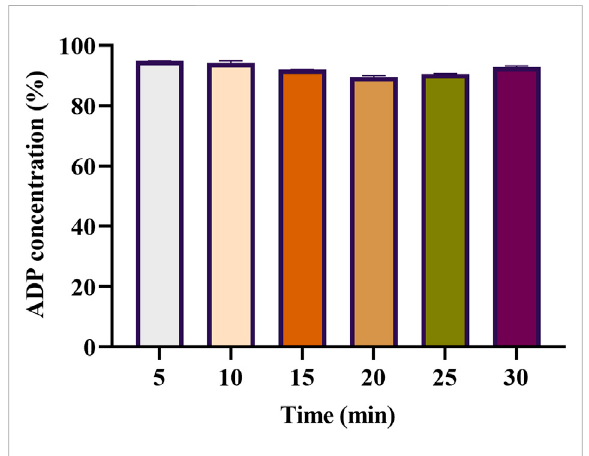
FIGURE 3 Graphical representation of the in vitro dissolution study for the assessment of the release of adapalene from the mucoadhesivevaginalgel( n =3).Thenumericvaluesonthe y -axis represent the percentage of dissolved adapalene (from the initial loaded dose 1 g of 1% adapalene muco-adhesive gel) and release pattern in the dissolution medium plotted against